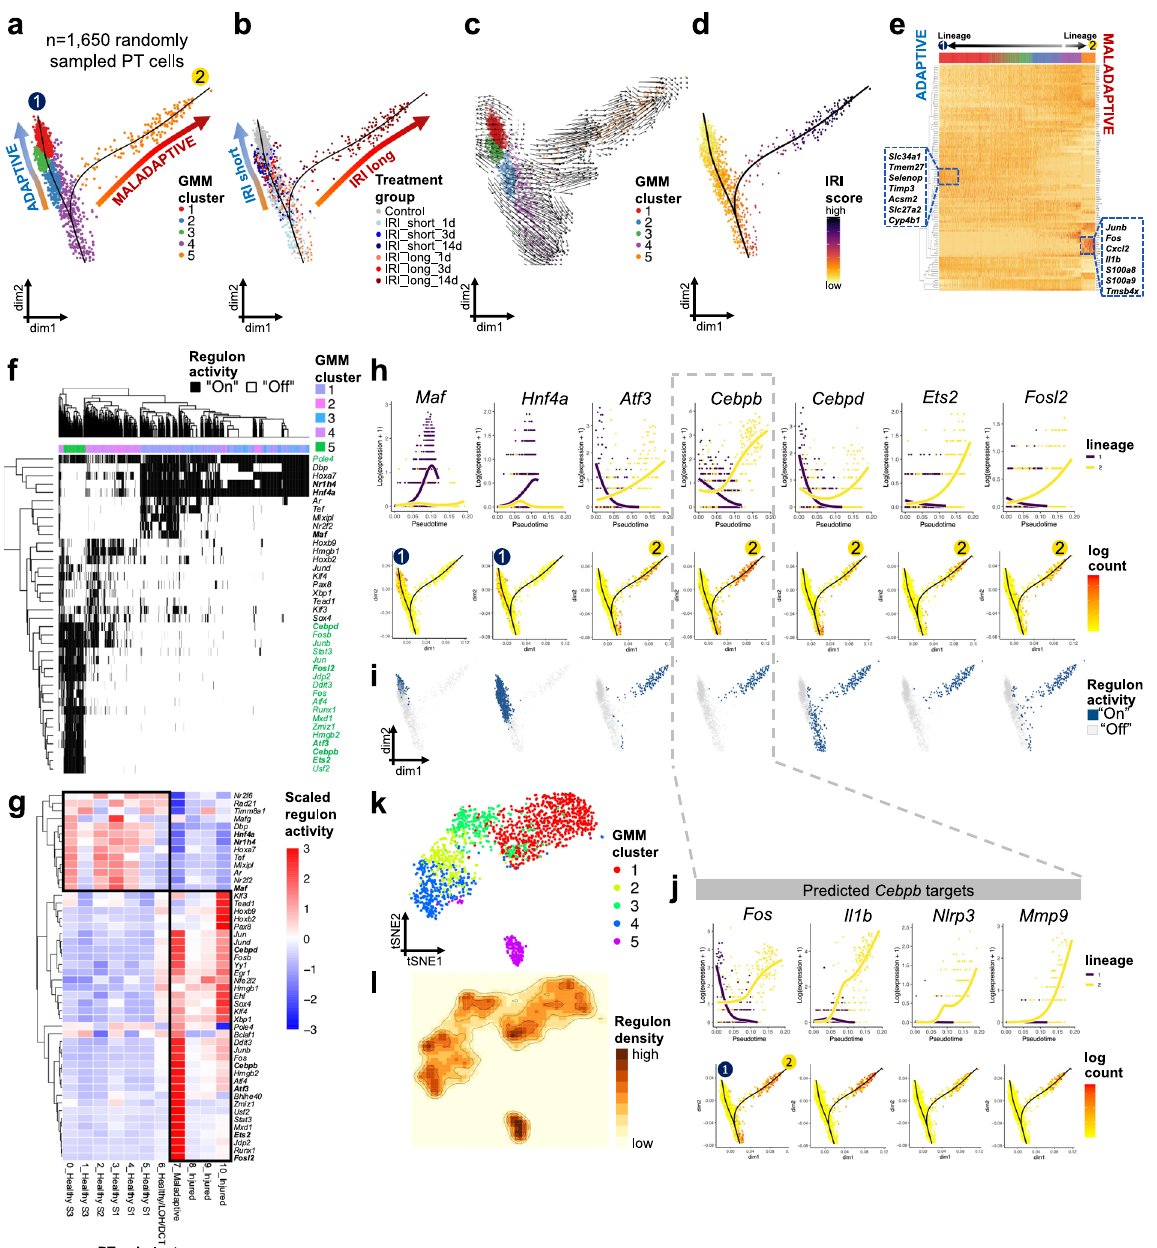
Fig. 4 PT trajectories of adaptive and maladaptive repair. a , b Slingshot-derived trajectories of 1,650 randomly sampled PT cells using Gaussian mixture modeling (GMM) yielded 5 clusters in 2 trajectories. GMM clusters ( a ) and treatment groups ( b ) demonstrated major overlap: Trajectory 1 represented adaptive repair of acutely injured cells 1 d post-ischemia (GMM4) towards endpoint clusters (GMM1&3) corresponding to control and short IRI 14 d samples. Trajectory 2 represented maladaptive repair of acutely injured cells (GMM4) towards fi broin fl ammation (GMM5). c RNA velocity analysis in the same 1650 PT cells recapitulated similar trajectories. Cells are colored by GMM clusters as in ( a ). d Steady IRI score increase along trajectory 2. e Heatmap showing generalized additive modeling (GAM)-derived differentially expressed genes (DEGs) along the 2 PT lineages following IRI. Rows represent DEGs, columns represent individual PT cells. Color legend at the top corresponds to GMM clusters from ( a ). The lineage 1 endpoint was exclusively from samples 14 d after short IRI and Controls, demonstrating increased expression of PT differentiation markers (e.g., Slc34a1, Acsm2 ). The lineage 2 endpoint was exclusively from samples 14 d after long IRI and showed increased in fl ammatory (e.g., Il1b, Cxcl2, S100a8, and S100a9 ) and stress marker (e.g., Junb, Fos ) expression. f Heatmap of cell type-speci fi c binarized regulon activity, as inferred by cis -regulatory network analysis using SCENIC. Rows represent regulon activity (binarized to “ on ” = black or “ off ” = white), columns represent individual PT cells. Color legend at the top displays GMM clusters. g Heatmap of PT subcluster-speci fi c scaled regulon activity. Rows represent regulons, columns represent PT subclusters. h , i Gene expression and regulon activity of exemplary lineage-speci fi c transcription factors (TFs) governing top speci fi c regulons. h Pseudotime-dependent gene expression along the 2 PT lineages and corresponding feature plots. i Binarized regulon activity (blue = “ on ” , gray = “ off ” ). Regulon activity and gene expression largely overlapped and demonstrated lineage-speci fi c patterns. j Gene expression of Cebpb targets, as predicted by motif analysis, showed strong increases of proin fl ammatory genes such as Il1b and Nlrp3 along lineage 2. k tSNE reduction plot of GMM clusters showing good separation of trajectory-inferred clustering. l tSNE representation of regulon density as a surrogate for stability of regulon states.